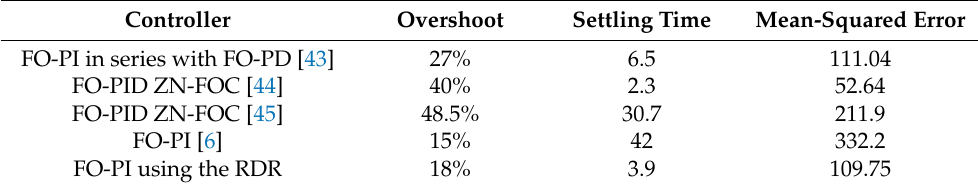
Figure 22. Reference tracking results for integrative time delay process (black line- FO-PI deisgned using the RDR, blue line- FO-PID designed by Monje 2006, red line- FO-PID designed by Muresan 2022, green line- FO-PID designed by Valerio 2006, magenta line- FO-PI designed by Monje 2010). Table 2. FO-PID controllers’ performance for reference tracking.